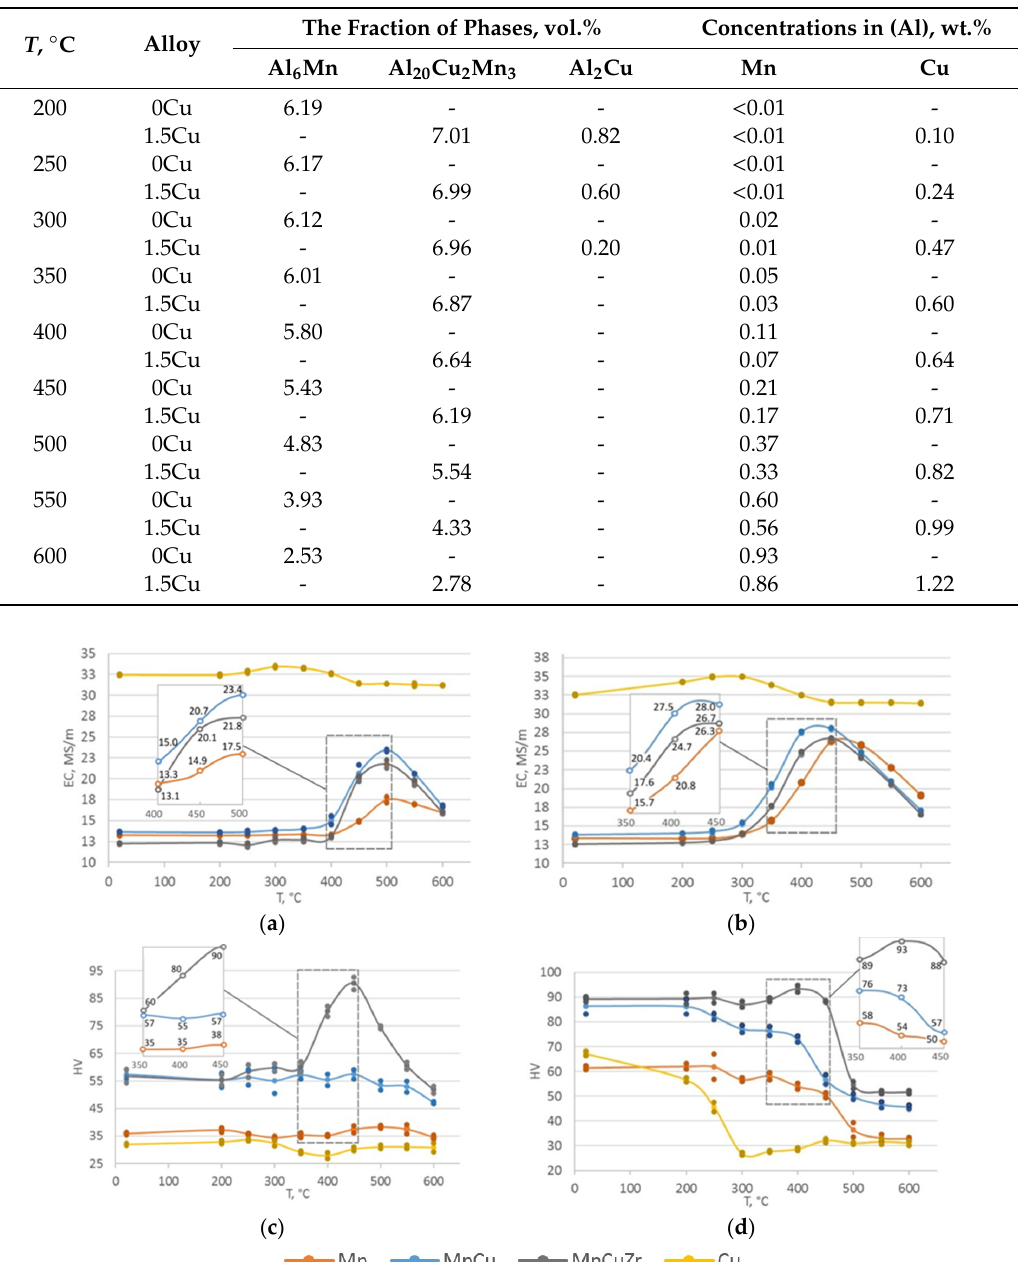
Table3. Calculateddataonthephasecompositionof1.5Mnand1.5MnCualloysatvarioustemperatures.